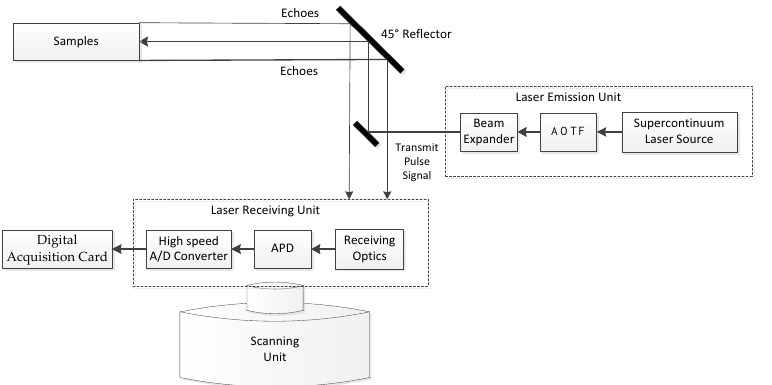
Figure 1. The optical layout of the HSL System.